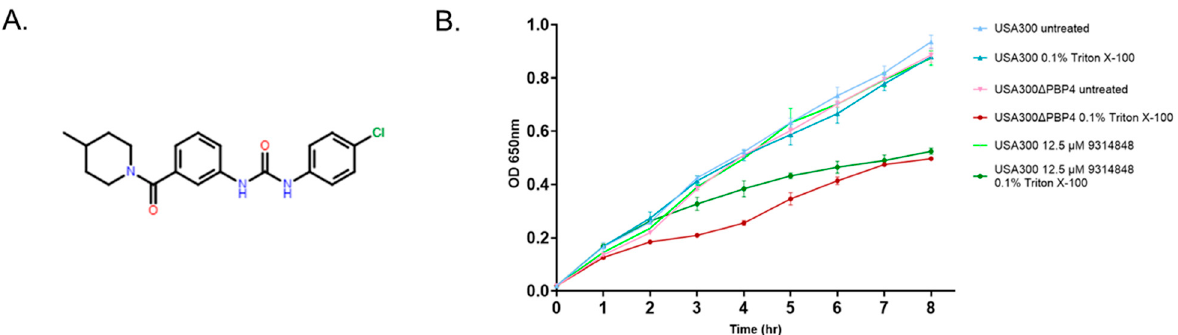
Figure 3. Characterization of highest priority putative S. aureus PBP4 inhibitor . Panel ( A ). Chemical structure of ChemBridge compound 9314848. Panel ( B ). Growth measures of S. aureus strains USA300, USA300 ∆ pbp4 , and 9314848 treated cells in the absence and presence of 0.1% of Triton-X100.